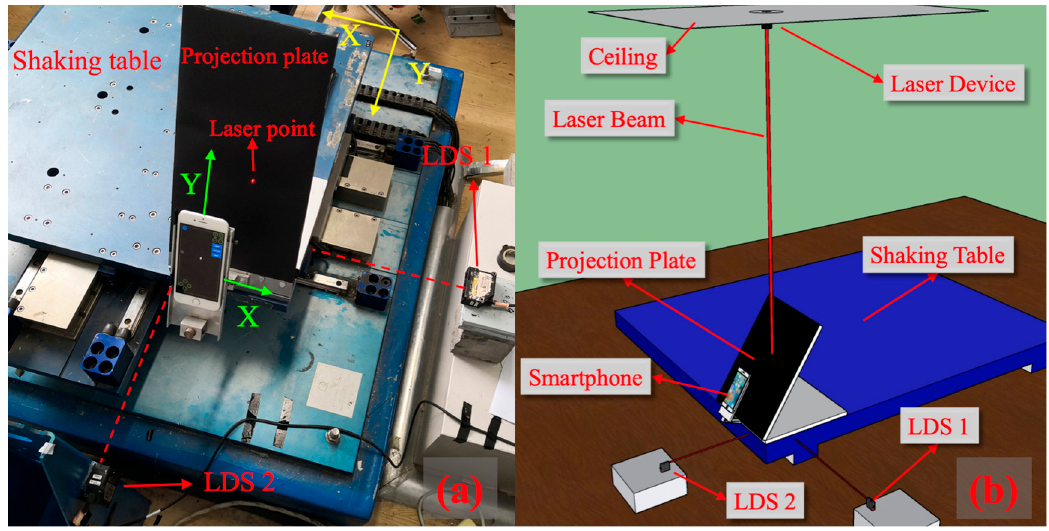
Figure 2. The layout of the experiments : ( a ) A close shot; ( b ) A schematic diagram.